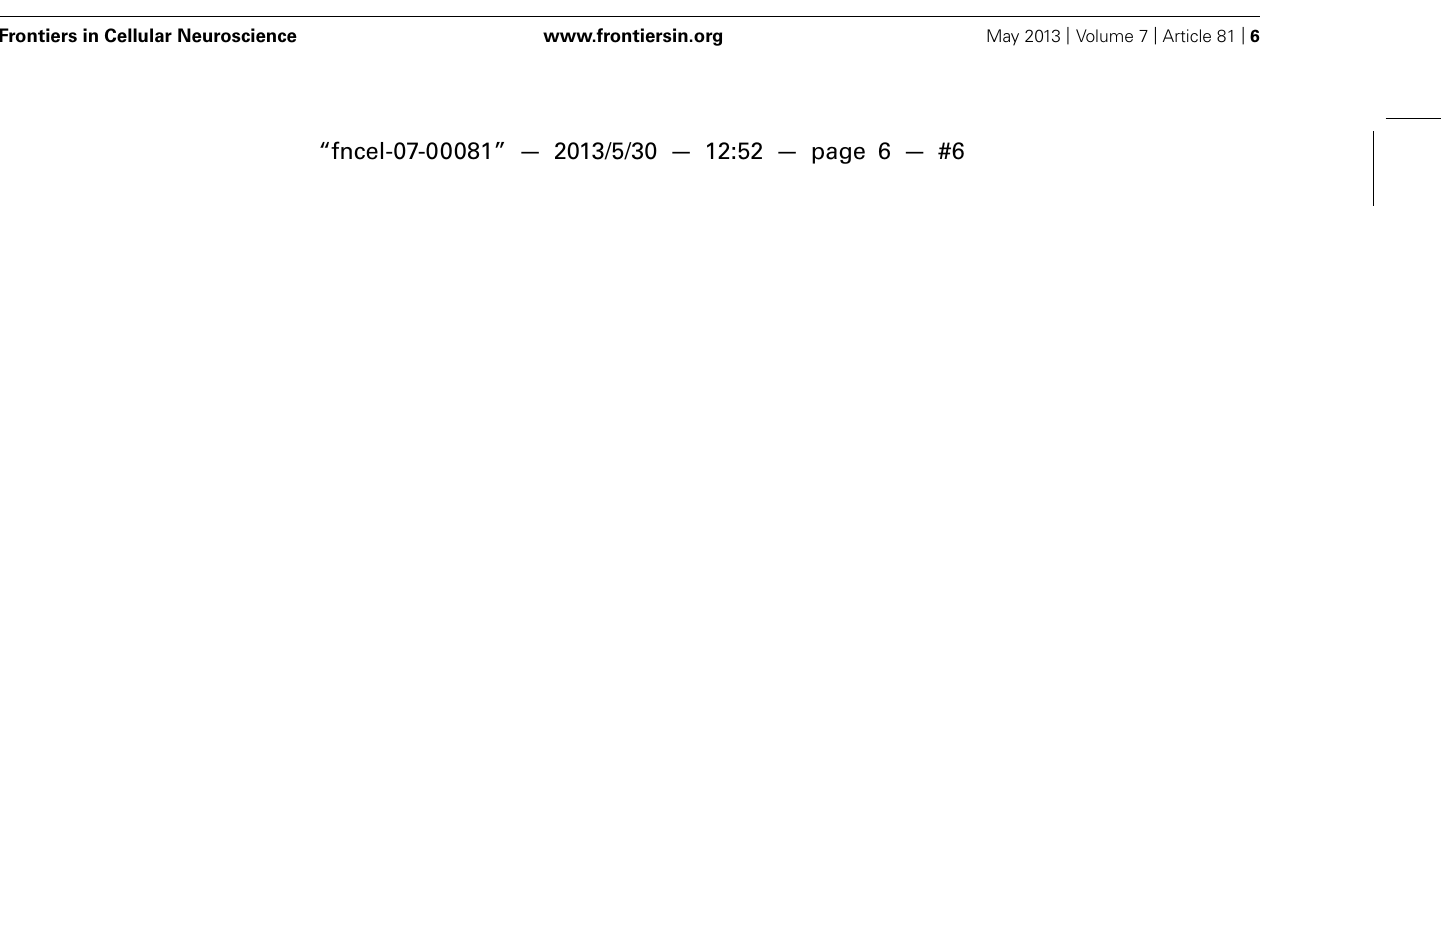
FIGURE 4 | Differential responses of cells with and without α -syn induction toAA exposure. 3D5/DAT cells with 8 days of RA-elicited differentiation plusTet-Off induced α -syn expression and their non-induced counterparts were treated with AA for 60 h and referred to as S + /AA and S − /AA, sibling cultures without treatment were used as controls and referred to as S + and S − , respectively. (A) Western blotting of cell lysates with antibodies to α -syn, LC3, active caspase 3, and GAPDH. (B–E) Bar graphs represent data obtained from quantitation of immunoreactivities displayed in (A) and western blot from two additional experiments.The results are representative of three independent experiments. Error bars represent SEM.